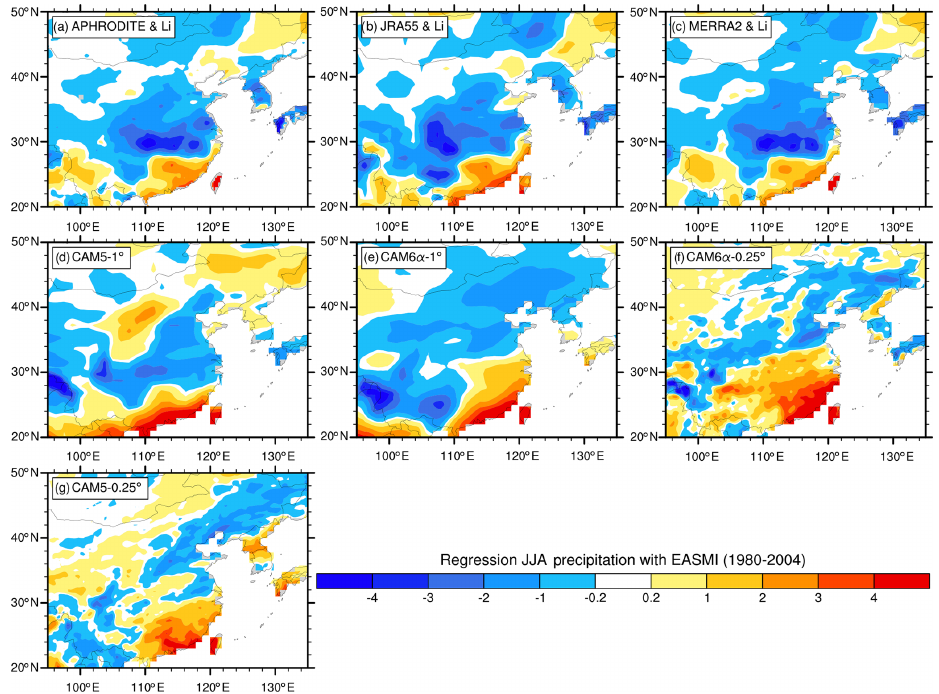
Figure 8. Regression of summer (JJA) precipitation onto EASMI (mmd − 1 ) for